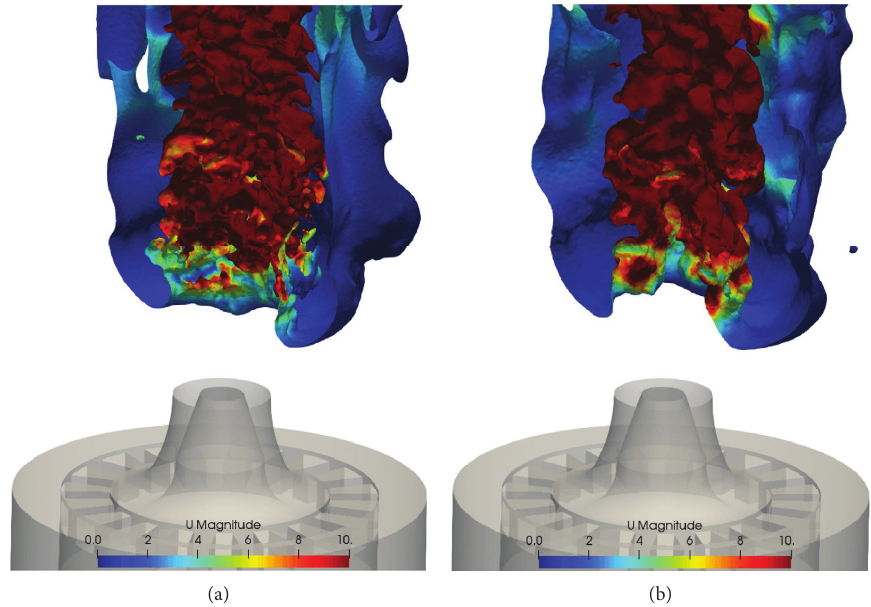
Figure 17: Contour of instantaneous temperature T (b).